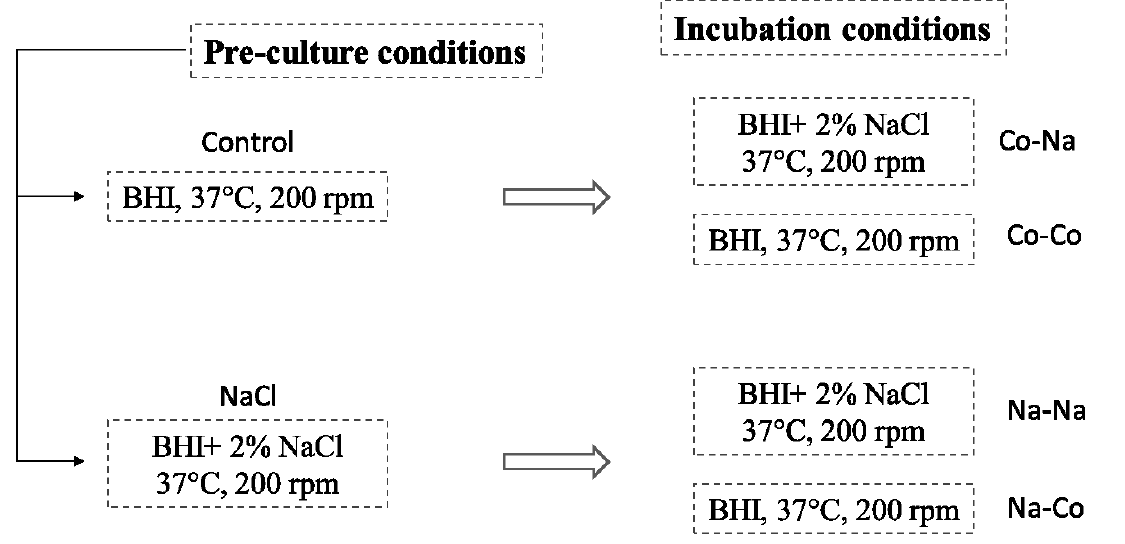
Figure 1. Schematic representation of the experimental set up of NaCl pre-stressed Sa17 cells and subsequent exposure to similar stress or optimal growth conditions. In total four different incubation conditions were investigated for sea gene regulation and SEA